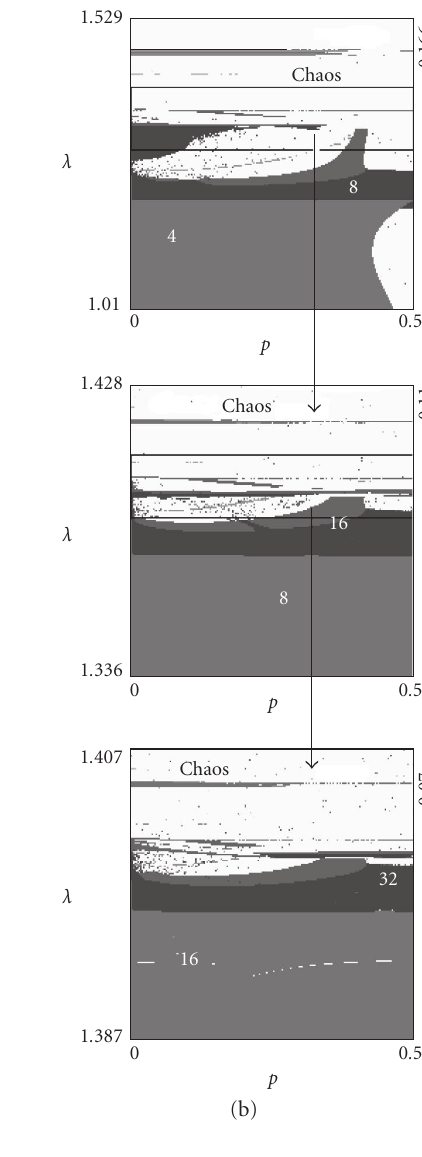
section (see also the figures’ captions), the factor of scaling for relative population num- bers equals 1. One can see that after the rescaling, similar structure in parameter space is